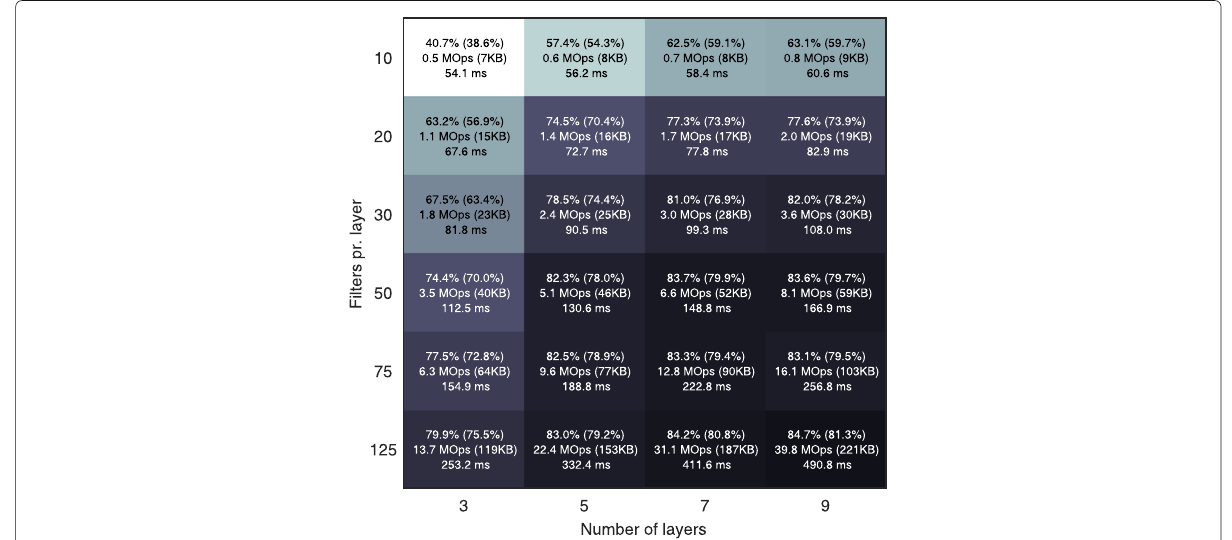
Fig. 6 Selection of hyper-parameter grid search. The first line in each box indicates the average accuracy in the range of 0 − 20 dB SNR for the matched and mismatched (in brackets) test. The number in the second line shows the number of operations and the required memory (in brackets). The third line indicates the execution time. The color indicates the accuracy (lighter color lower accuracy)